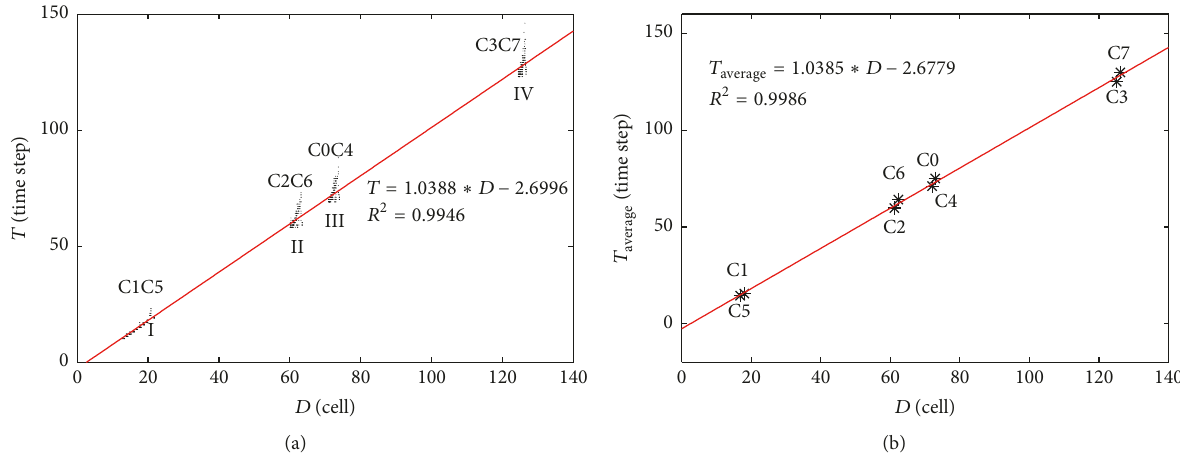
Figure 9: The relationships between 𝑇 , 𝑇